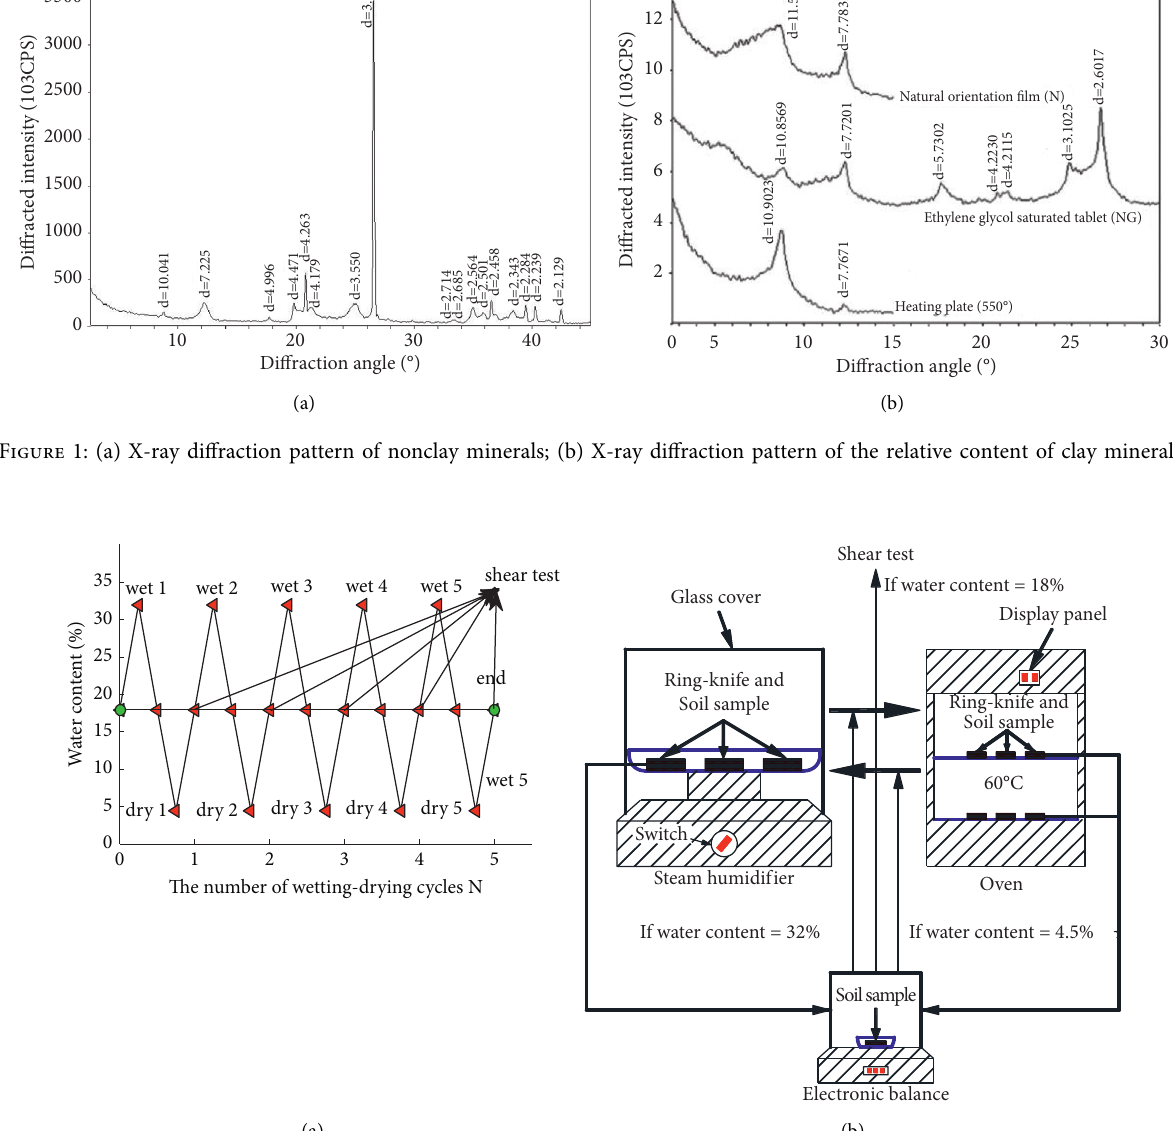
where c N is the cohesion, N is the number of wetting-drying cycles, and A N , B N , and D N are parameters related to the initial state. For the soil used in this study, A N � 28.78, B � 0.5885, and D � 32.99, with a correlation coefficient N N of R 2 � 0.9877.